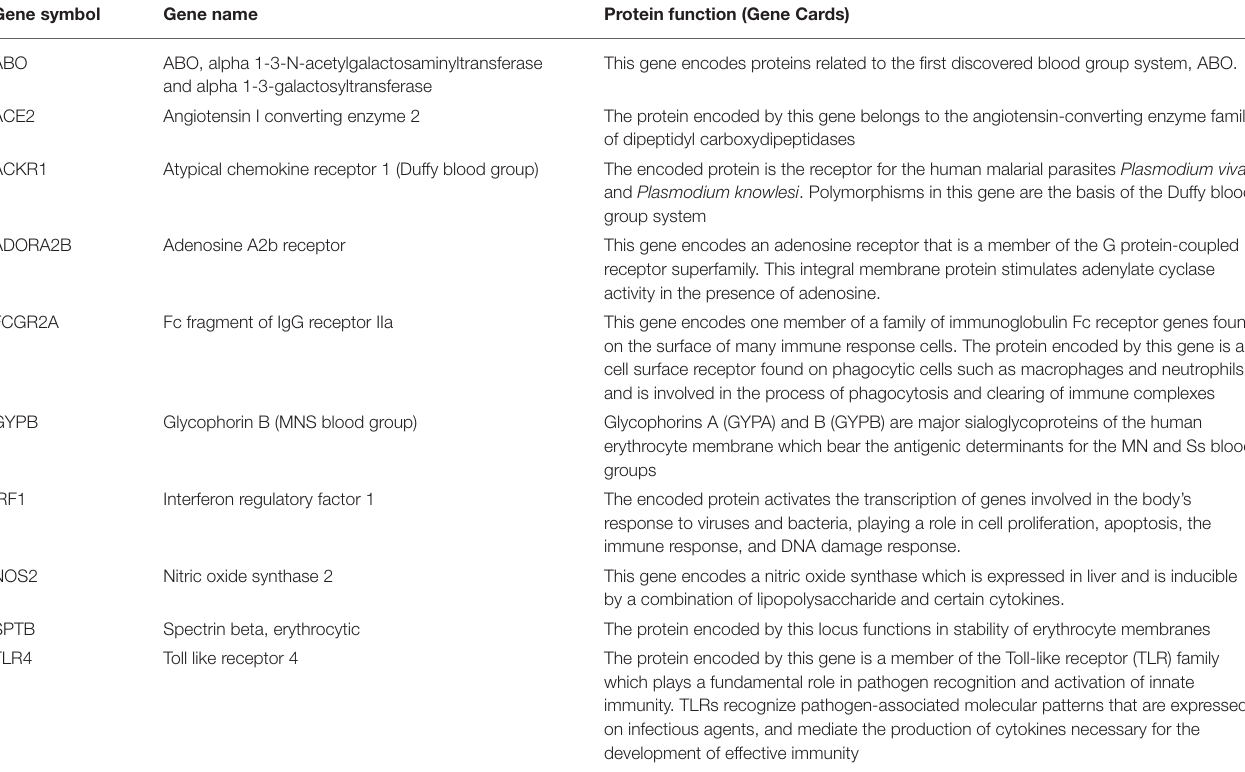
TABLE 4 | List of genes with variants significantly (FDR < 0.01) correlated (positively or negatively) to COVID-19 cases. Gene symbol